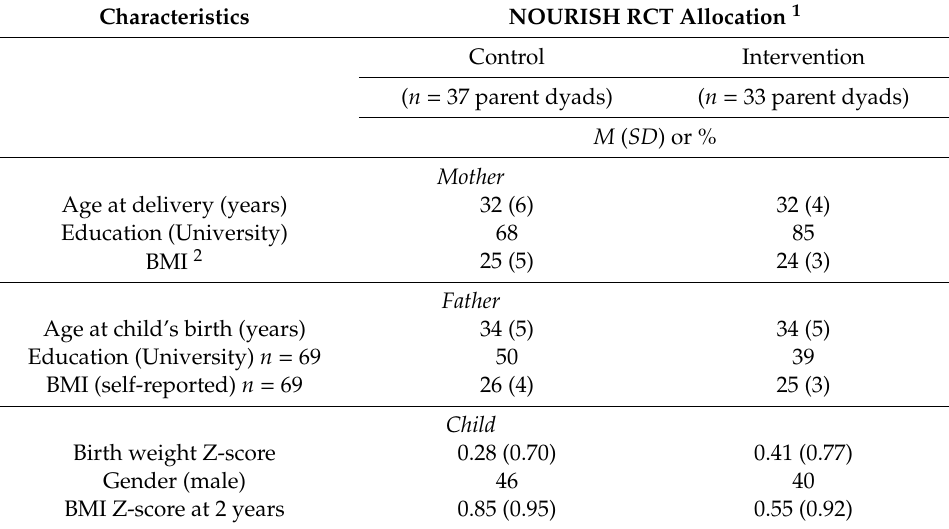
(Table 1). All analyses were conducted in IBM SPSS Statistics (version 24) and a significance level of p < 0.05 (two-tailed) was used throughout. Table 1. Characteristics of study participants ( N = 70 parent